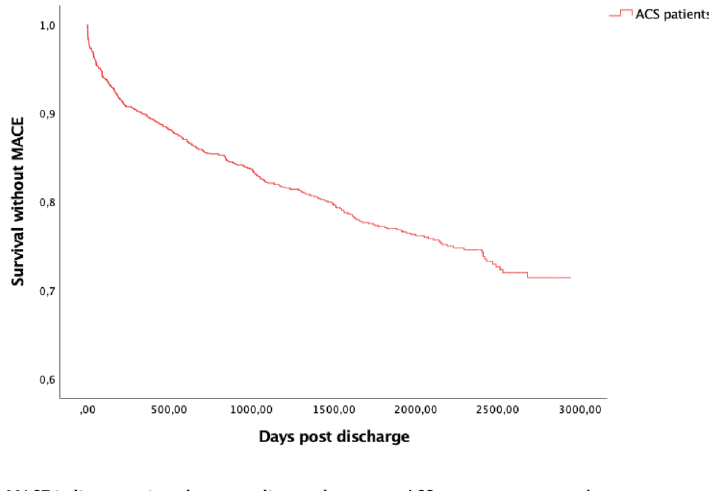
Figure 2. Cumulative Kaplan–Meier estimate of survival without MACE among 1379 patients discharged after hospitalization for ACS between 1 Jan 2010 and 31 Dec 2014.